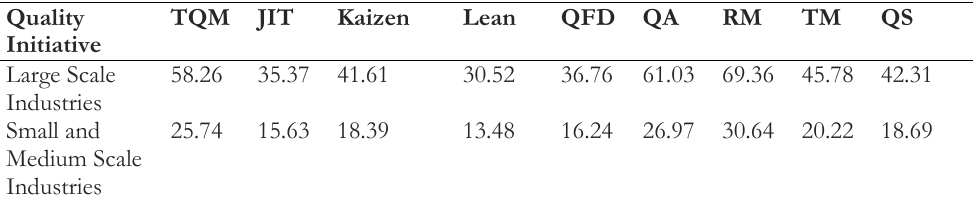
Table 2. Expected values of responses for quality initiatives.